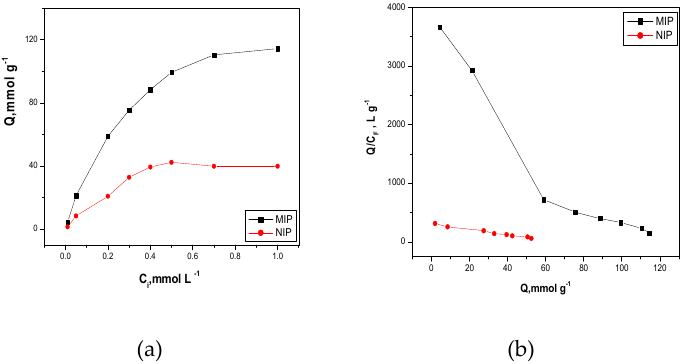
Figure 3. ( a ) Binding isotherm ( Q = mmol/g) is plotted as a function of byspyribac concentration, C = mmol/L); and ( b ) Scatchard plot ( Q/C free = L/g is plotted as a function of Q = mmol/g). Q is the